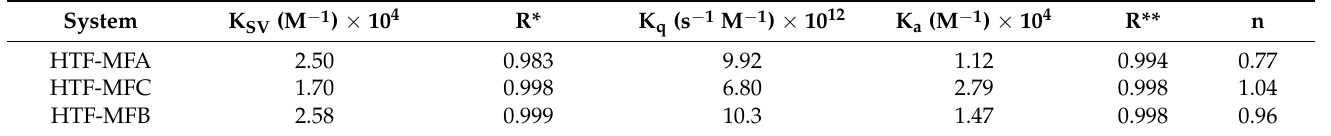
Table 1. Biophysical parameters of holo-transferrin (HTF) interactions with 6-methylflavanone biotransformation products were determined from the Stern-Volmer and Scatchard equations at 23 ◦ C. The Stern–Volmer quenching constant (K SV ), bimolecular quenching constant (K q ), binding constant (K a ), and binding sites per protein molecule